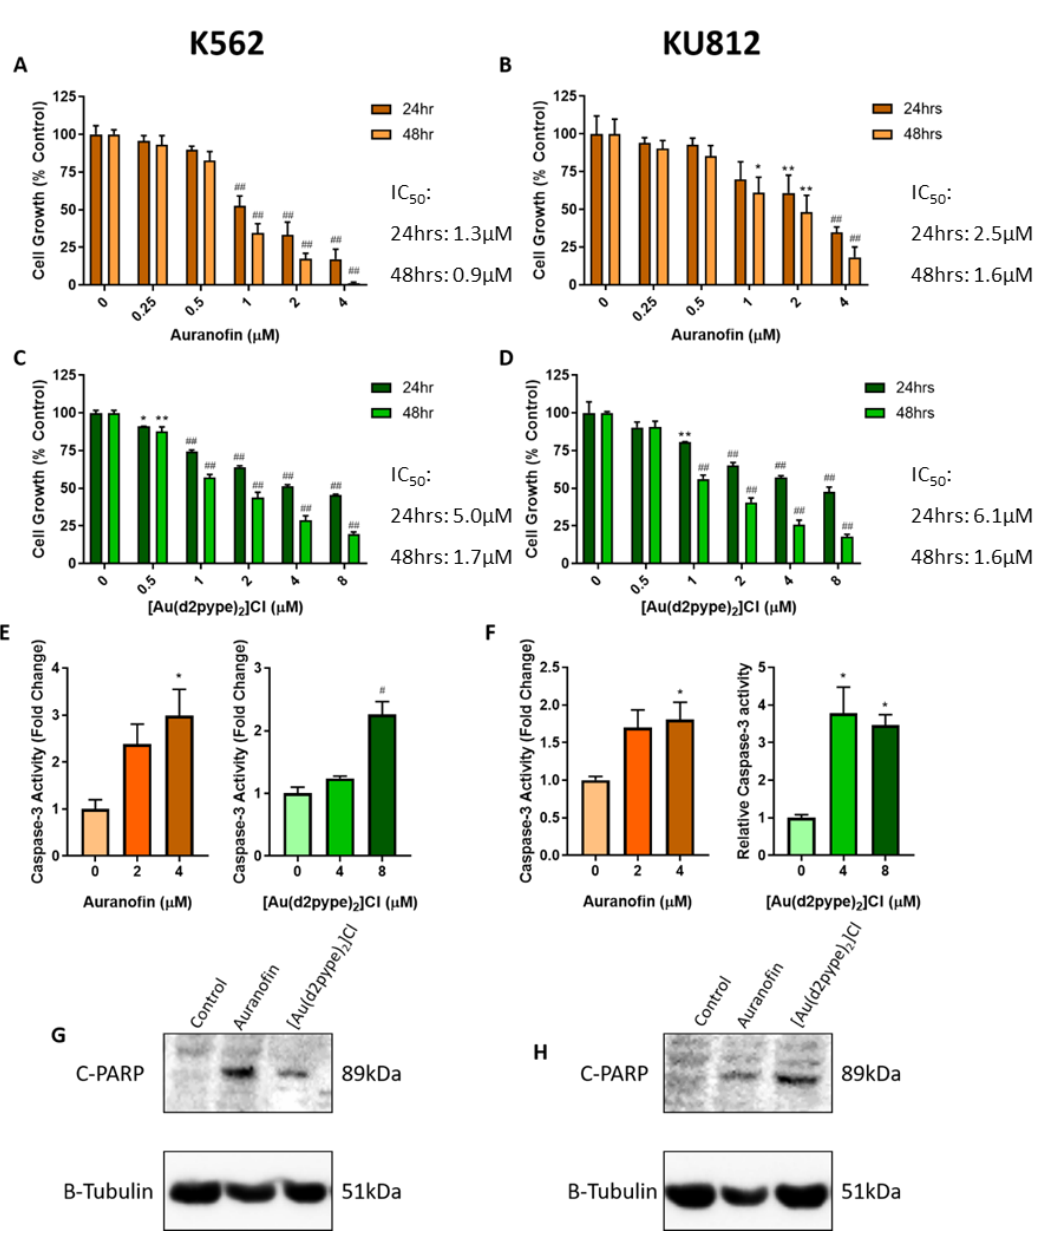
Figure 1. TrxR Inhibitors Reduce Cell Growth and Elicit Apoptosis in CML Cells. A-D: K562 and KU812 cells were treated with auranofin ( A,B ) and [Au(d2pype) 2 ]Cl ( C,D ) respectively for 24 and 48hrs. Cell growth was then measured using the MTT proliferation assay. E,F : K562 and KU812 respectively were treated with auranofin or [Au(d2pype) 2 ]Cl for 24 hrs then caspase-3 activity